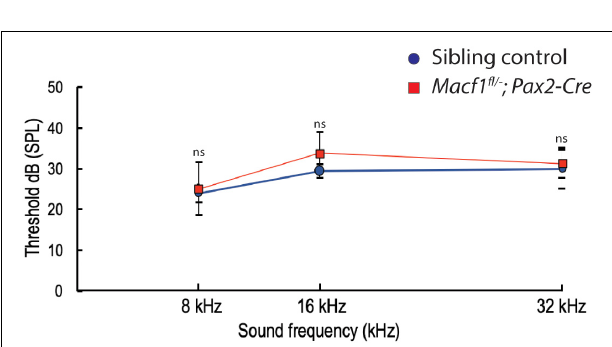
FIGURE 5 | Auditory brainstem response (ABR) thresholds of Macf1 fl / − ; Pax2-Cre and sibling control mice. Thresholds at 8, 16, and 32 kHz show no statistical significance between Macf1 fl / − ; Pax2-Cre mice and controls. n = 5 control mice and n = 6 Macf1 fl / − ; Pax2-Cre mice. Error bars are represented as the standard deviation and significance was determined with an unpaired Student’s t -test. dB,